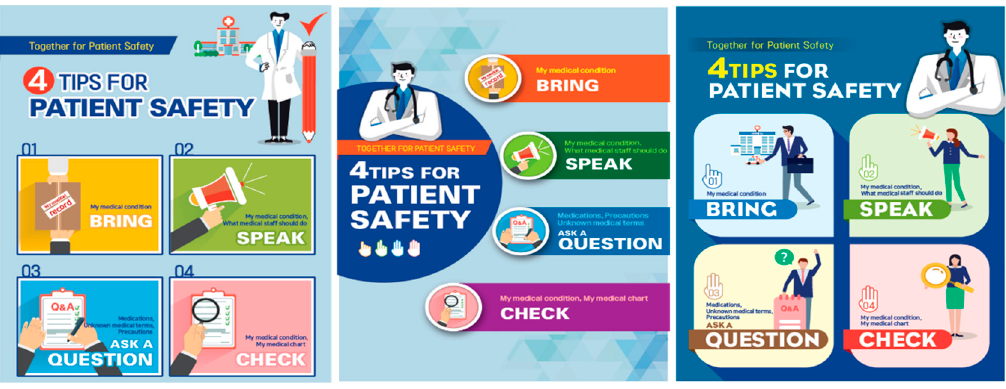
Figure 2. Patient safety educational materials.